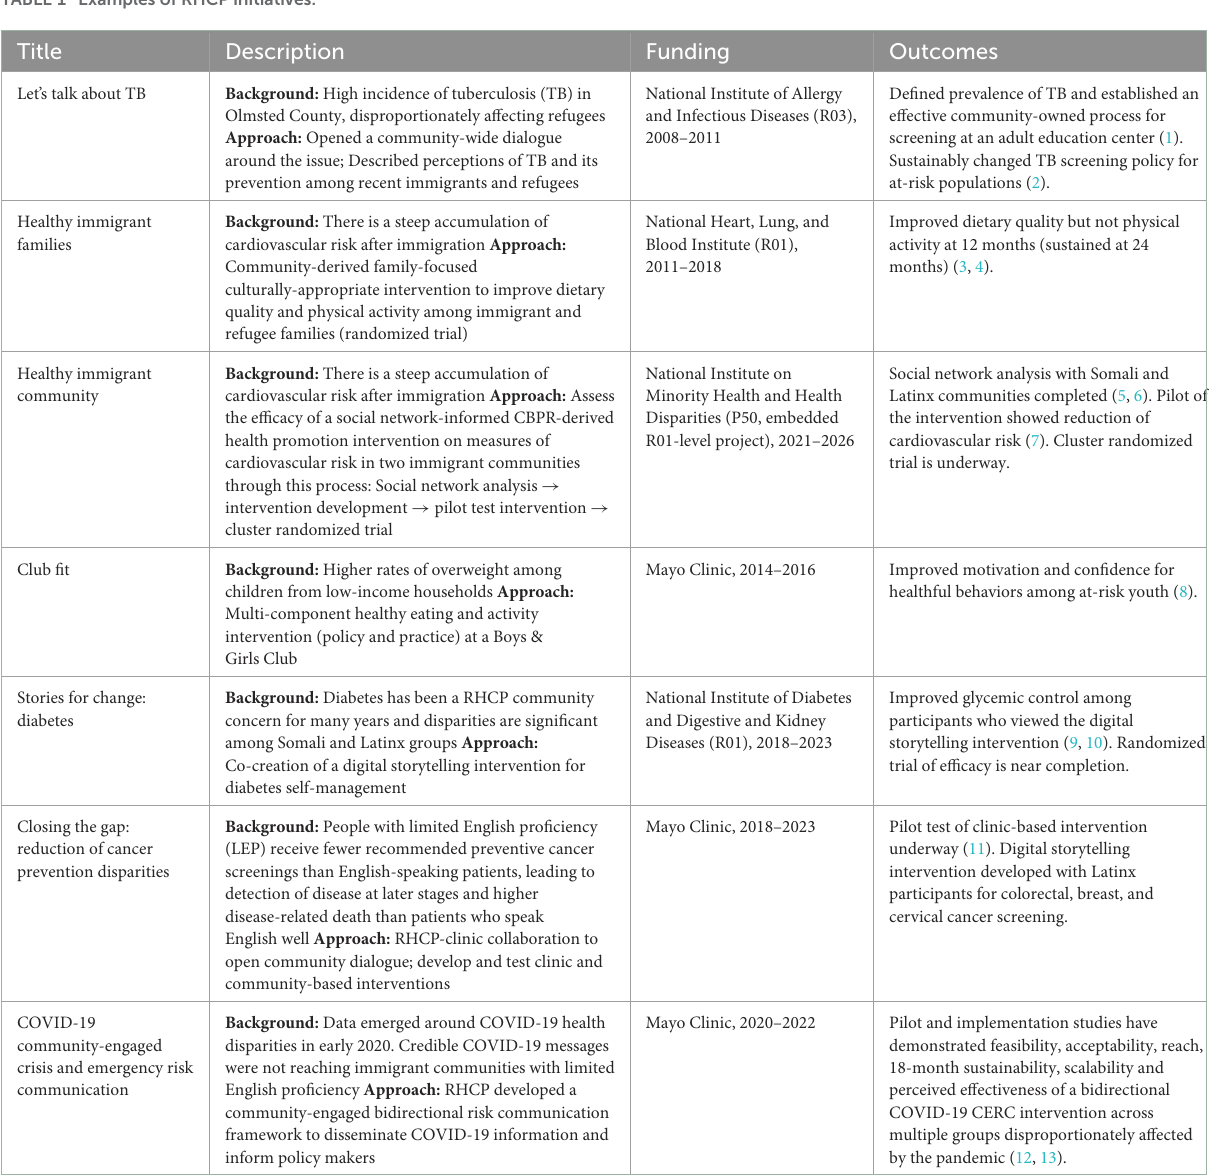
TABLE 1 Examples of RHCP